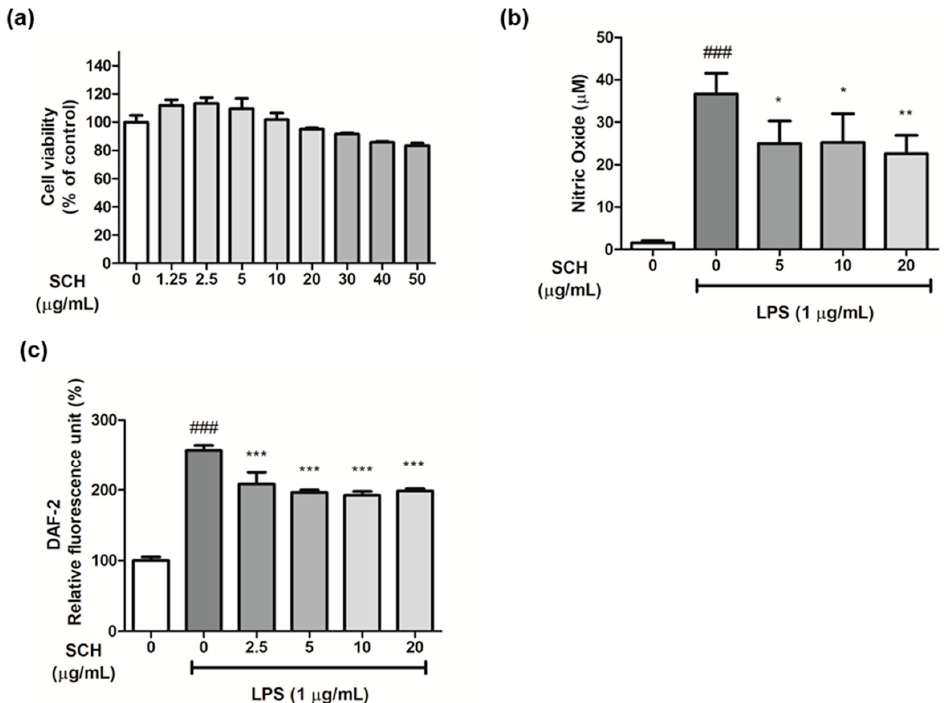
Figure 5. Effect of SCH on Raw 264.7 cell viability and NO production. ( a ) Effect of SCH on Raw 264.7 cell viability. ( b , c ) Effects of SCH on LPS-induced nitric oxide production as determined by ( b ) Griess reaction and ( c ) DAF-FM DA fluorescence assay. Results are presented as means ± SDs. # p < 0.05 vs. non-treated controls. * p < 0.05 vs. LPS treated cells.